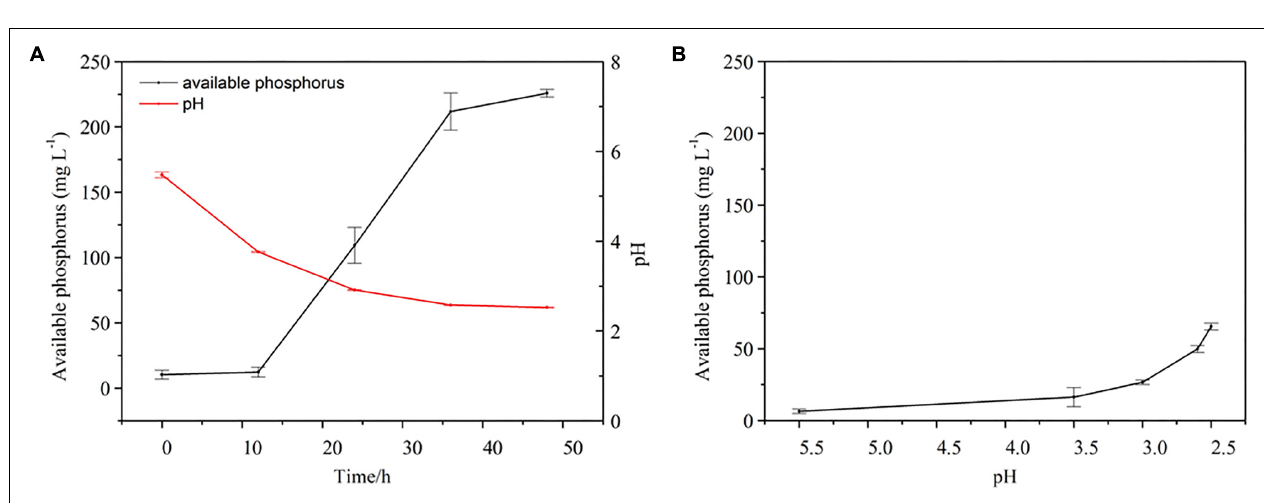
FIGURE 3 | Comparison of Al-P and Fe-P solubilizing abilities of Nguyenibacter sp. L1. (A,B) Available P concentration (A) and pH (B) of the culture medium after culturing Nguyenibacter sp. L1 with AlPO 4 or FePO 4 as the P source at 30 ◦ C for 48 h. Vertical bars represent standard deviations of the means ( n = 3). Different capital and lowercase letters above columns indicate significant differences ( p < 0.05) between two P sources after culture for 0 and 48 h, respectively. Asterisks above columns indicate significant differences ( p < 0.01) between 0 and 48 h.